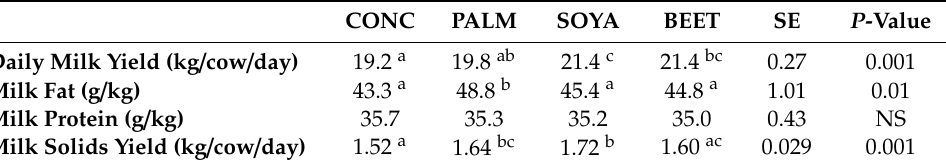
Table 4. The e ff ect of dietary treatment (parlour concentrate, palm kernel expeller, soya hulls, and molassed beet pulp) on milk production and milk composition, during the experimental period (23 July to 31 August). CONC PALM SOYA BEET SE P